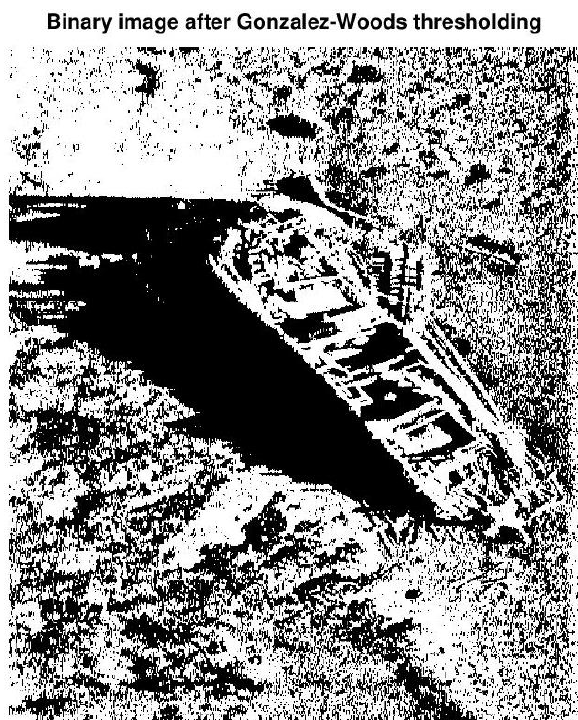
Figure 5. Binary image after Gonzalez–Woods